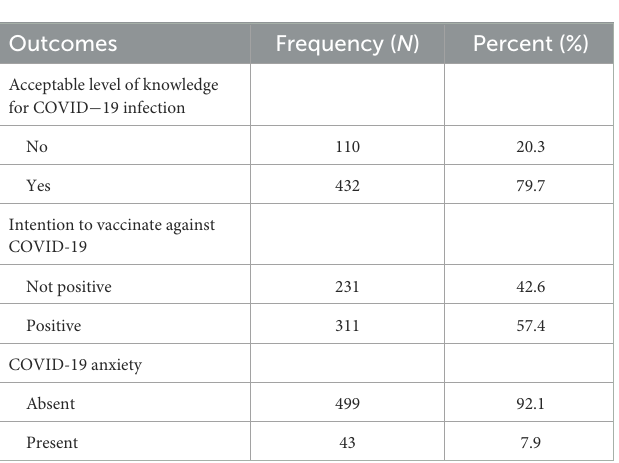
TABLE 3 Characteristics of outcome variables ( N =